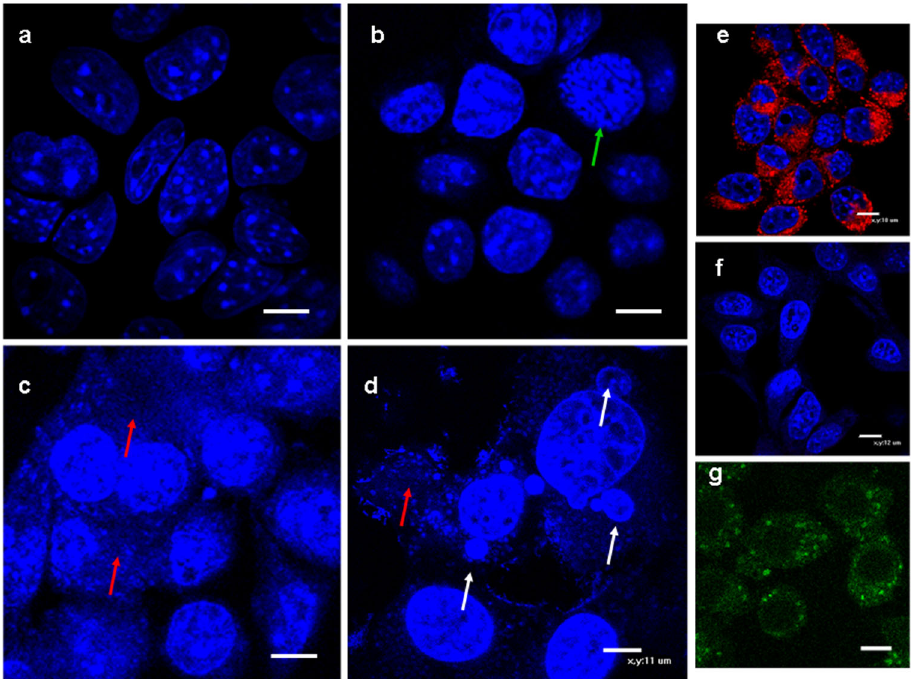
Figure 8. Biological effects induced by compound 7c in vitro. Confocal microphotographs of control ( a , e ) and compound 7c treated (5 µ M) ( b , c , f , g ) for 24 h MCF7 cells stained with Hoechst33342 ( a – f ), LysoTrackRed ( e , f ), and DCF ( g ). Release of nuclear material into cytoplasm ( c , d , red arrows), disassembling of chromosomes (green arrow), large vesicles in the cytoplasm of the cells (white arrows), depolarization of lysosomes ( f ), and ROS production ( g ) show different types of cell death under compounds 7 influence. Scale bar is 10–15 µ